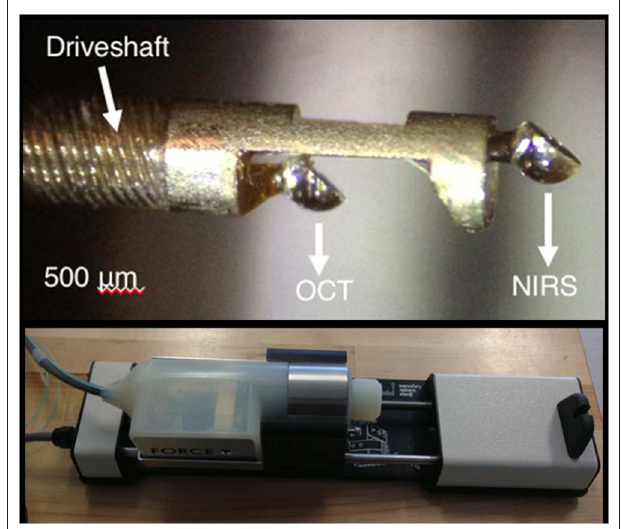
FIGURE 8 | A close-up of the tip of the prototype OCT-NIRS catheter created by the Tearney Lab. Light travels down a first optical fiber, and returns to provide the NIRS signal in a second optical fiber.